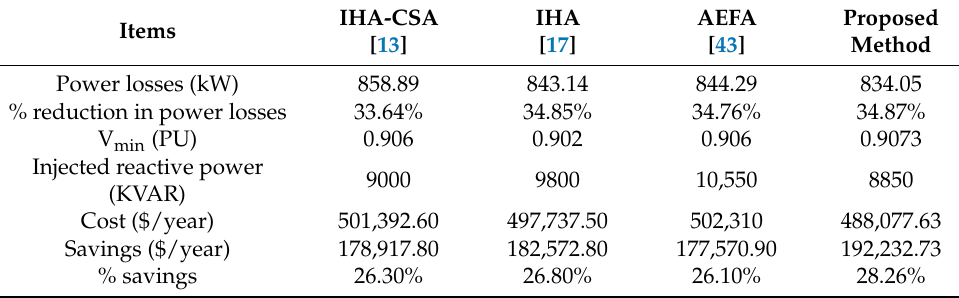
Table 8. IEEE 119 system with capacitor allocation